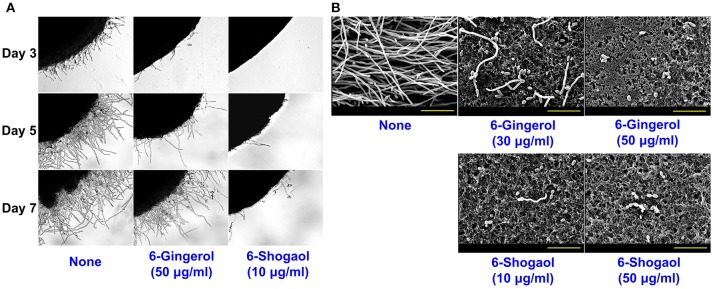
Effects of 6-gingerol and 6-shogaol on the hyphal morphogenesis of C. albicans. C. albicans morphology on solid media (A). C. albicans was streaked on PDA solid plates in the absence or presence of 6-gingerol or 6-shogaol. Colony morphologies were observed during incubation for 7 days at 37°C. Inhibitions of hyphal growths by 6-gingerol or 6-shogaol in C. albicans biofilms were visualized by SEM (B). The scale bar represents 30 μm. None; non-treated control.